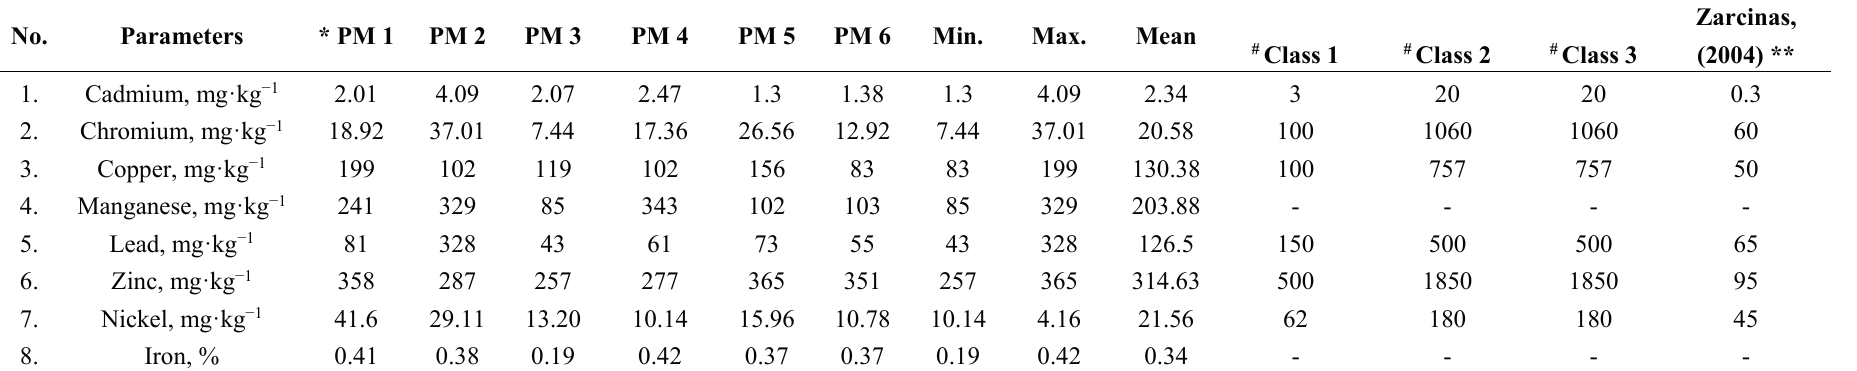
Table 2. Heavy metals content of recycled paper mill sludges of different paper mill